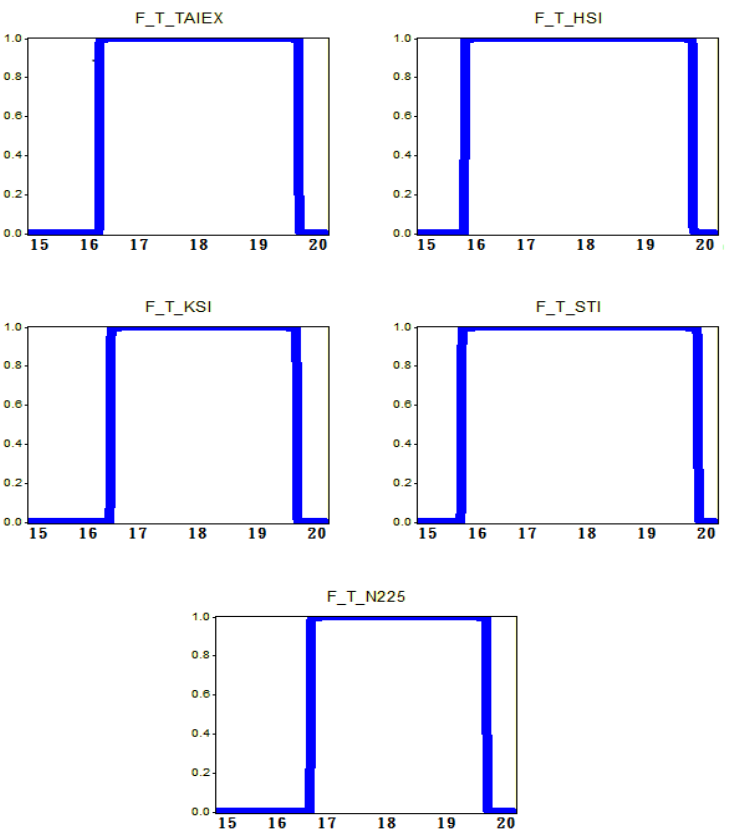
Figure 2: Estimation of smooth transition functions for stock market indices of the Four Asian Tigers and Japan.